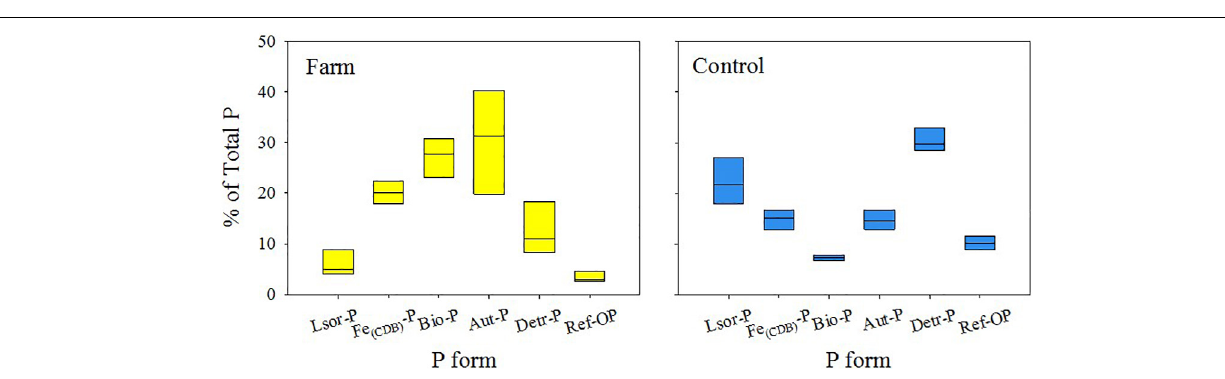
The high proportion of Aut-P together with the high PO 43